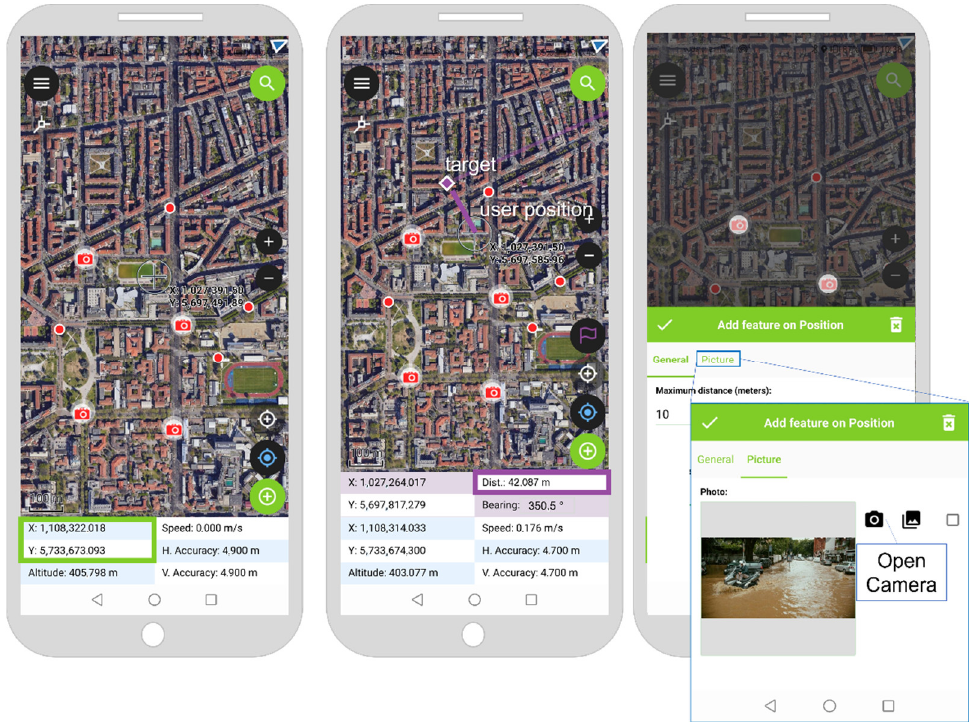
Figure 13. Screenshot of the QField project, showing how the map is used to help the user check their position and the collected data, and how the metadata are acquired in the process.